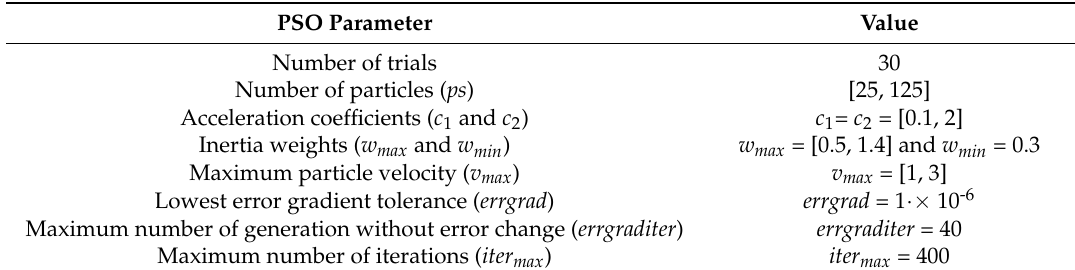
Table 2 . Configuration parameters of the PSO algorithm. Table 2. Configuration parameters of the PSO